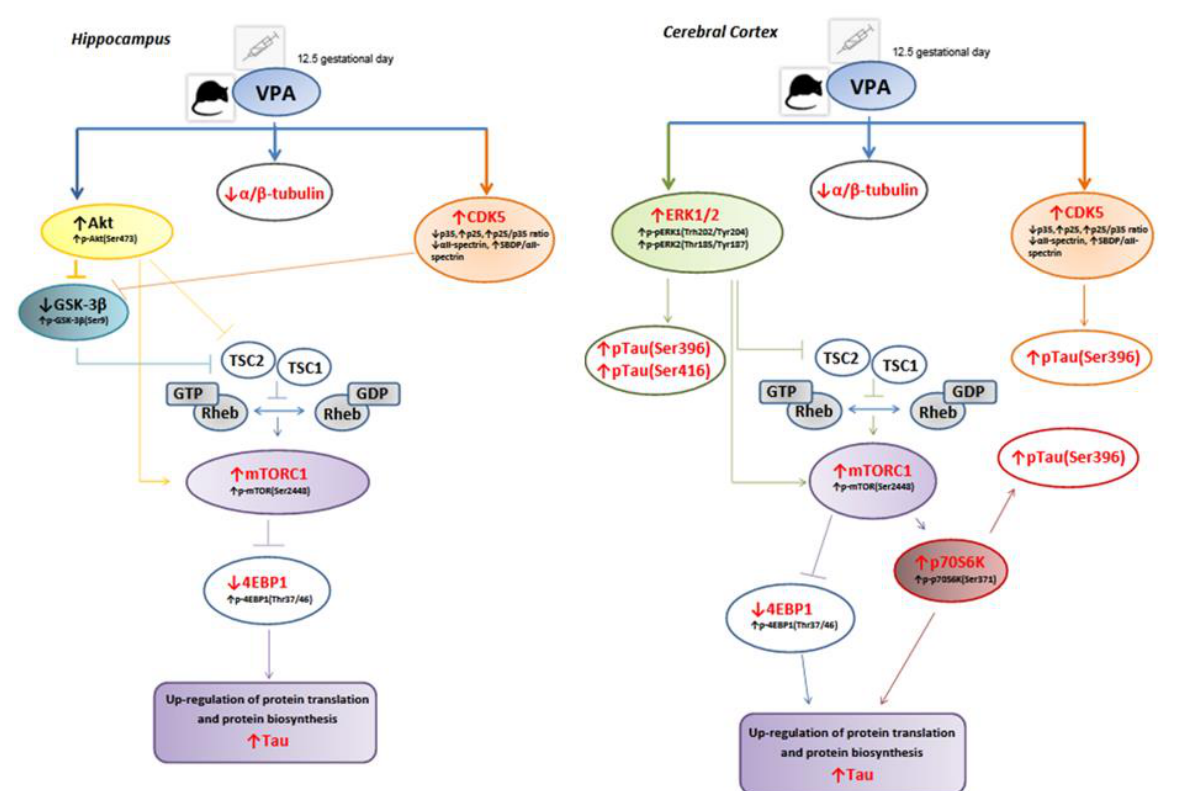
Figure 17. Schematic diagram showing the effect of prenatal exposure to VPA on the pathological changes in the brains of young-adult male offspring. A single i.p. injection of VPA at 12.5 days of pregnancy induced a disturbance in homeostasis of microtubule-associated proteins (significantly decrease in the level of α/β-tubulin together with an excessive rise in total Tau level) in the hippocampus and cerebral cortex of young-adult offspring. Additionally, hyperphosphorylation of Tau protein (significantly increase in the level of pTau(Ser396) and pTau(Ser416)) was observed exclusively in the cerebral cortex of VPA rats. The effect of VPA on the potential molecular mechanisms responsible for Tau dyshomeostasis as well as the Tau-kinases activity was brain structure-specific. In the hippocampus, deregulation of Akt/GSK-3β/mTORC1 pathway and activation of CDK5 kinase have been proposed as potential triggers of a molecular cascade leading to Tau accumulation. In turn, in the cerebral cortex, the involvement of MAPK-ERK1/2/mTORC1 signalling deregulation in Tau dyshomeostasis is suggested. Moreover, in addition to the CDK5 kinase, the involvement of ERK1/2 and p70S6K has been proposed as critical in the stimulation of Tau protein phosphorylation in the cerebral cortex of VPA offspring. Table 2. The effect of prenatal exposure to VPA on the changes in neuronal cytoskeletal proteins, the activity of Tau kinases, and deregulation of Akt/mTOR pathway in the rat brain. ( ↓ )—decrease level; ( ↑ )—increase level; (-)—without